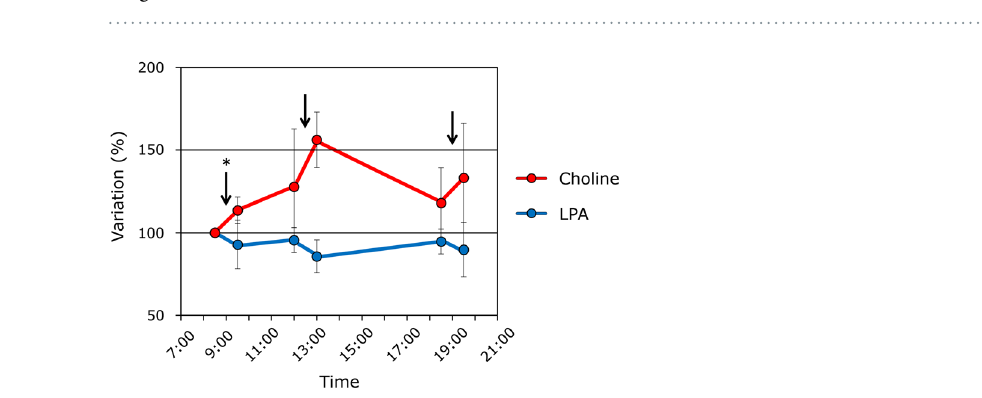
Table 1. Correlation between plasma choline level and various parameters. The number of samples examined ranged from 79 to 98.